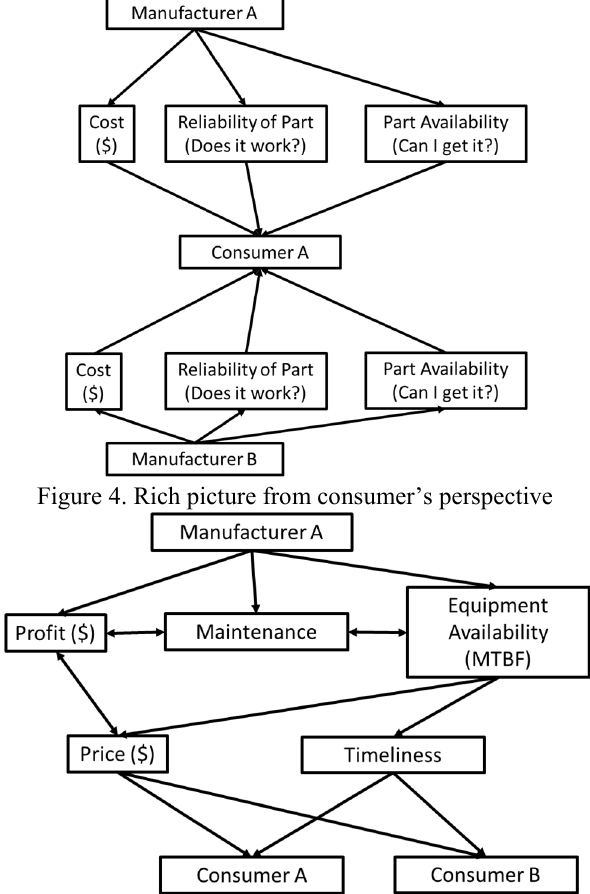
Figure 5. Rich picture from manufacturer’s